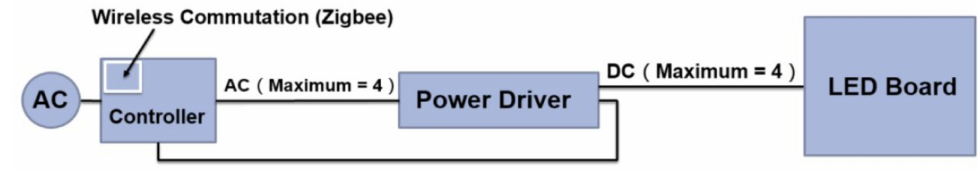
Figure 16. Schematic diagram of the human-centric intelligent LED roadway lighting control